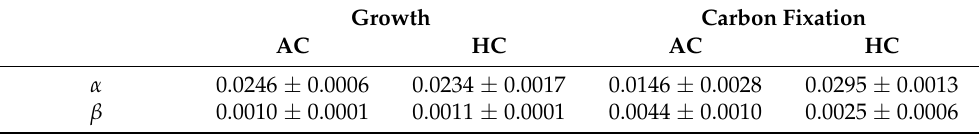
Figure 2. Photosynthetic carbon fixation of Synechococcus per cell ( a ) or per Chl a ( b ) grown under different light levels combined with the ambient (AC, 415 µ atm, the dotted line) or elevated (HC, 1000 µ atm, the solid line) p CO 2 . The values are means ± SD of triplicate cultures. Different letters indicate significant ( p < 0.05) differences among the treatments. Table 1. The light harvesting efficiency ( α ) and photoinhibitory coefficient ( β ) of Synechococcus CB0101 grown under different light levels combined with ambient (AC, 415 µ atm) or elevated p CO 2 (HC, 1000 µ atm), derived from the growth and carbon fixation curves at the growth intensity (Figures 1 and 2a),